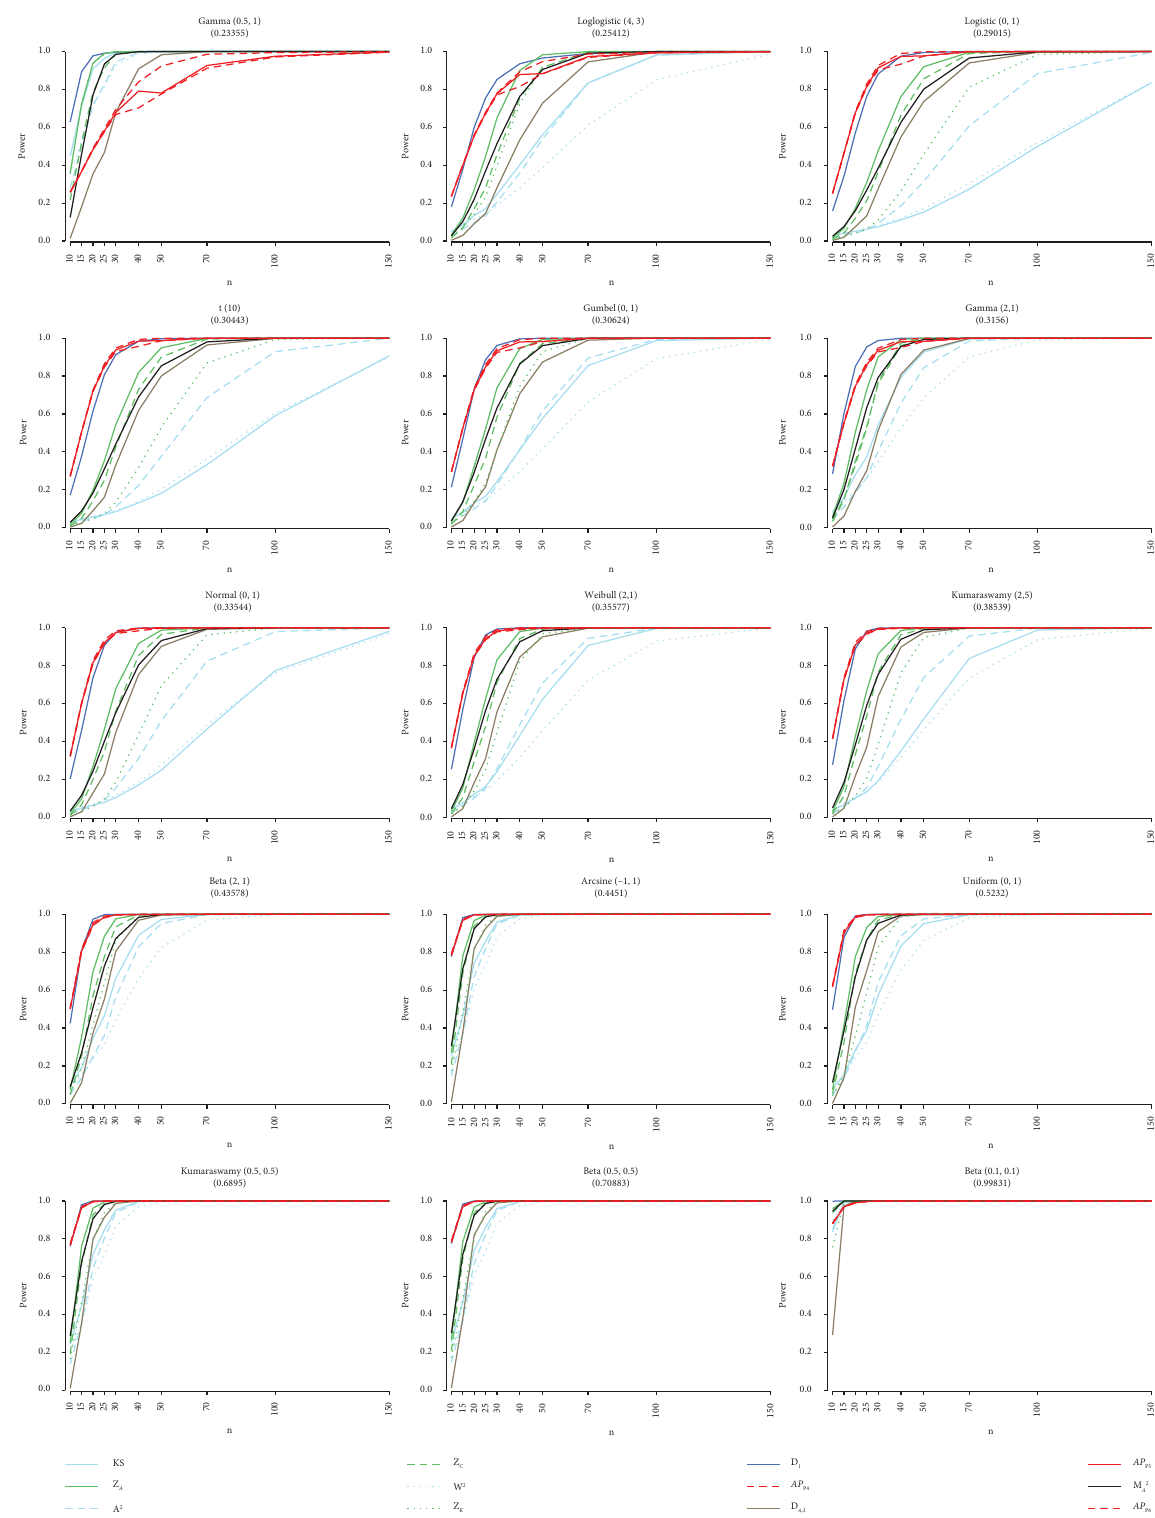
Figure 3: Te empirical powers for diferent alternative distributions